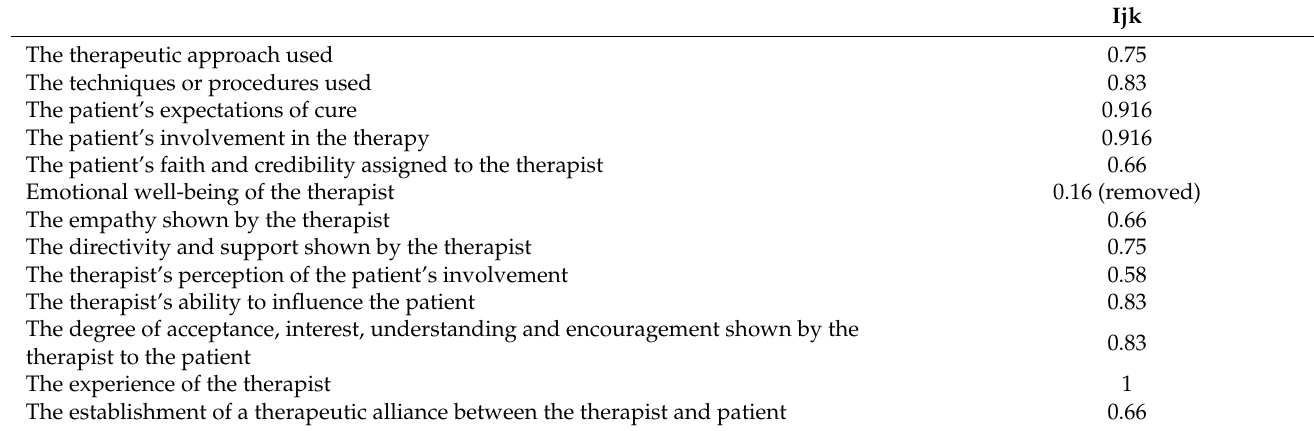
Table 2. Expert judgement. Congruence indices based on the objective congruence method (12 experts).